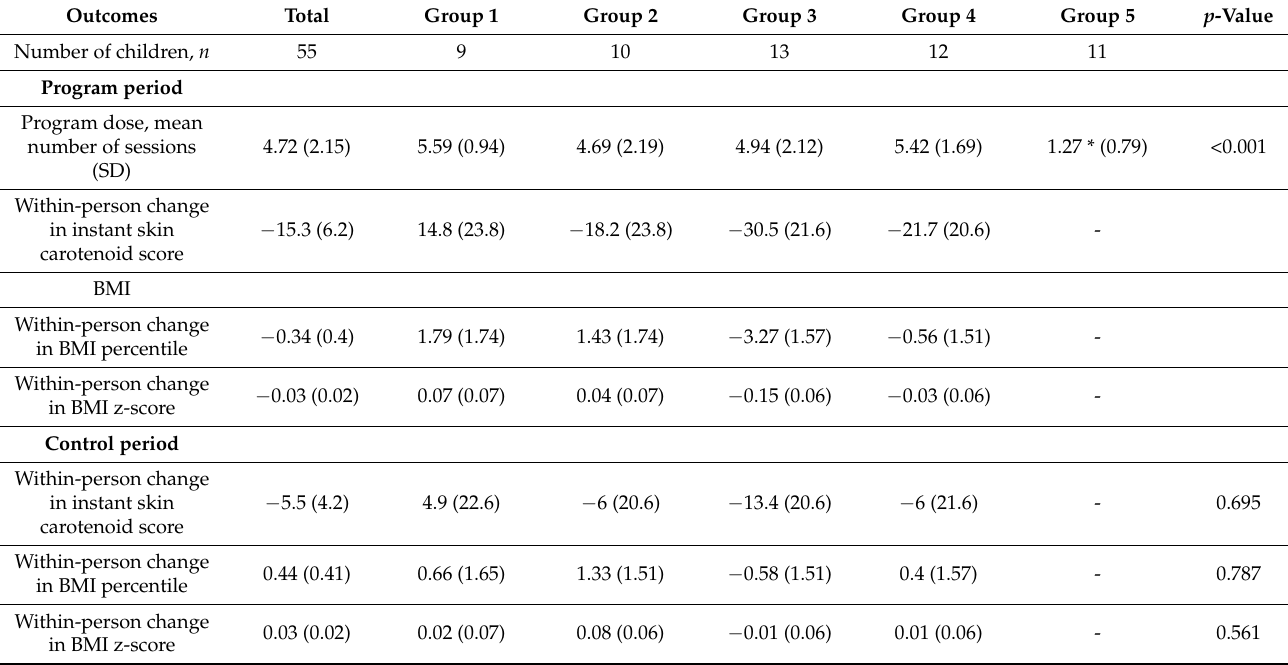
BMI: Body Mass Index; SD Standard Deviation. Data for 55 children excluding four children with missing outcome data at all four data collection time points. This table presents changes in outcomes between the pre-test (baseline) and post-test measures for intervention groups. Promotoras completed post-test measures six weeks after baseline. p -values are for uncorrected overall p -value for analysis of variance (ANOVA) for differences in mean